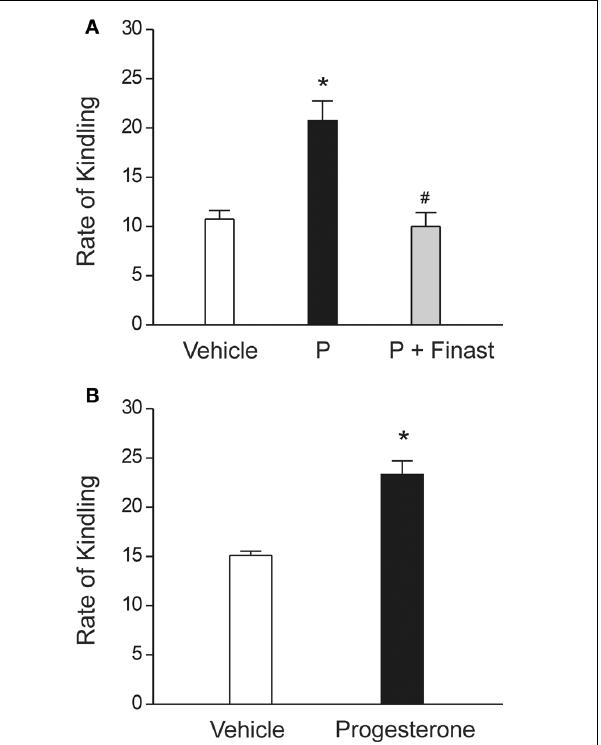
FIGURE 3 | Role of neurosteroids in the limbic epileptogenesis. (A) Rapid kindling. Mice treated with the neurosteroid precursor progesterone (P) displayed marked retardation of rapid hippocampus epileptogenesis, as expressed by a slower rate of kindling development for stage 5 seizures. P’s inhibition of kindling epileptogenesis was blocked by finasteride. P (25mg/kg, sc) was given 30-min prior to stimulation sessions and finasteride (50mg/kg, ip) was injected 1h before P treatment. * p < 0.01 vs. vehicle control, # p < 0.01 vs. P treatment alone. Adapted from Reddy and Mohan (2011). (B) Regular kindling. Rate of kindling (number of stimulations required to elicit behavioral stage 5 seizures) was significantly delayed in progesterone-treated animals. Progesterone (25mg/kg, sc) was given 30-min prior to stimulation sessions. Adapted from Reddy et al. (2010).